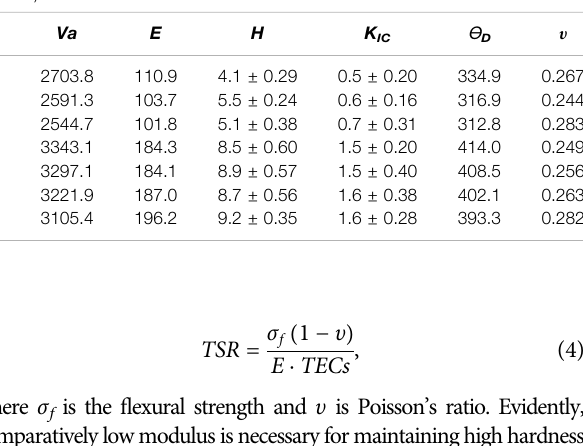
TABLE 2 | The average acoustic velocity (V a /m · s − 1 ), Young ’ s modulus (E/GPa), hardness(H/GPa),Debyetemperature( Ɵ D /K),Poisson ’ sratio( υ ),andfracture toughness (KIC/MPa · m 1/2 ) of (La1-xHox) 3 NbO 7 ( x (cid:2) 0/6, 1/6, 2/6, 3/6, 4/6, 5/6, and 6/6)